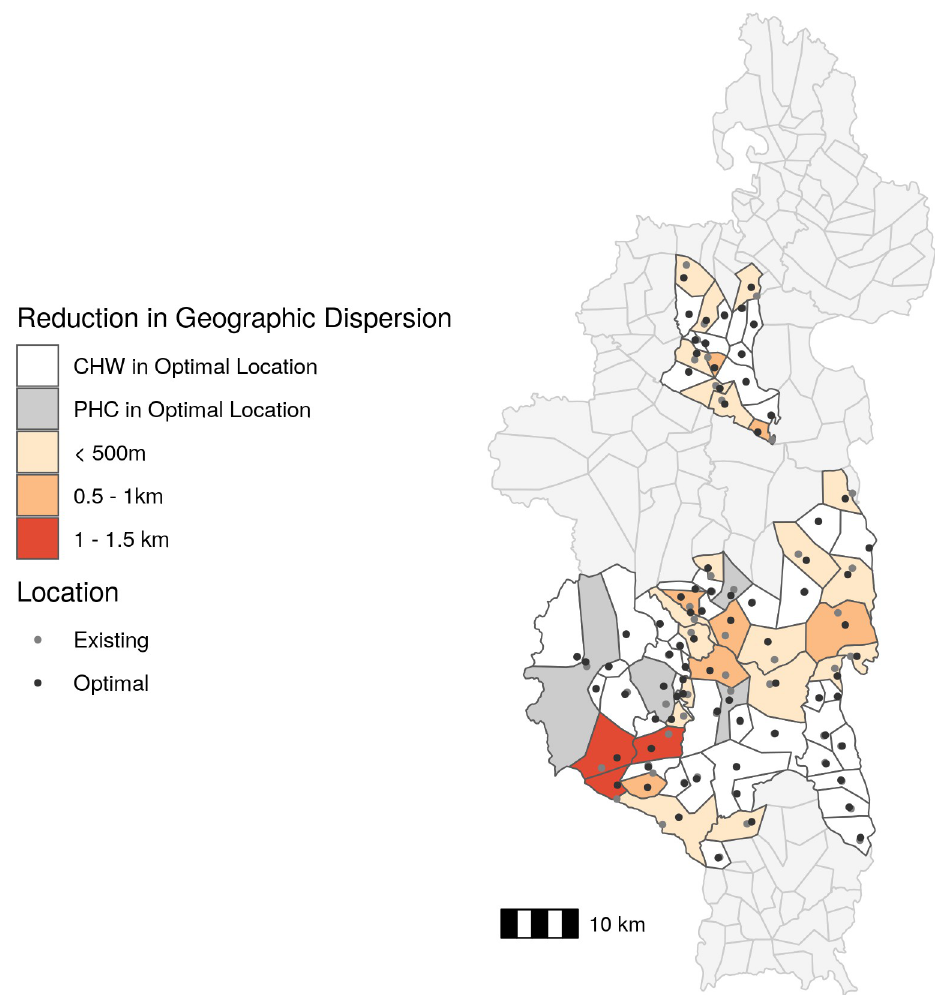
Fig 3. The majority of existing CHW sites are located near the optimal location. Absolute change in CHW geographic dispersion based on optimal CHW site location compared to existing CHW site location. The fill color represents the reduction in geographic dispersion and points represent existing site locations (gray) and optimal site locations (black). CHW: community health worker, PHC: primary health center. Data Sources: MMoPH (administrative boundaries), Pivot (health center locations), OpenStreetMap (transportation routes, buildings). All maps have been created from spatial datasets using the R programming